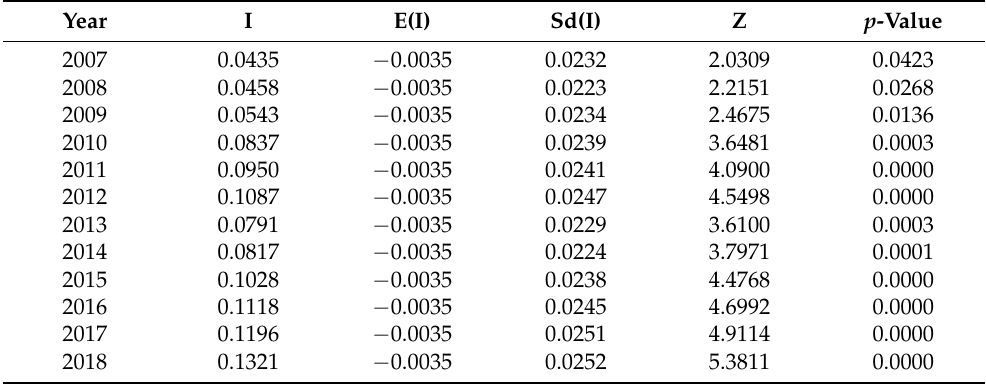
Table 6. Global Moran’s index of green